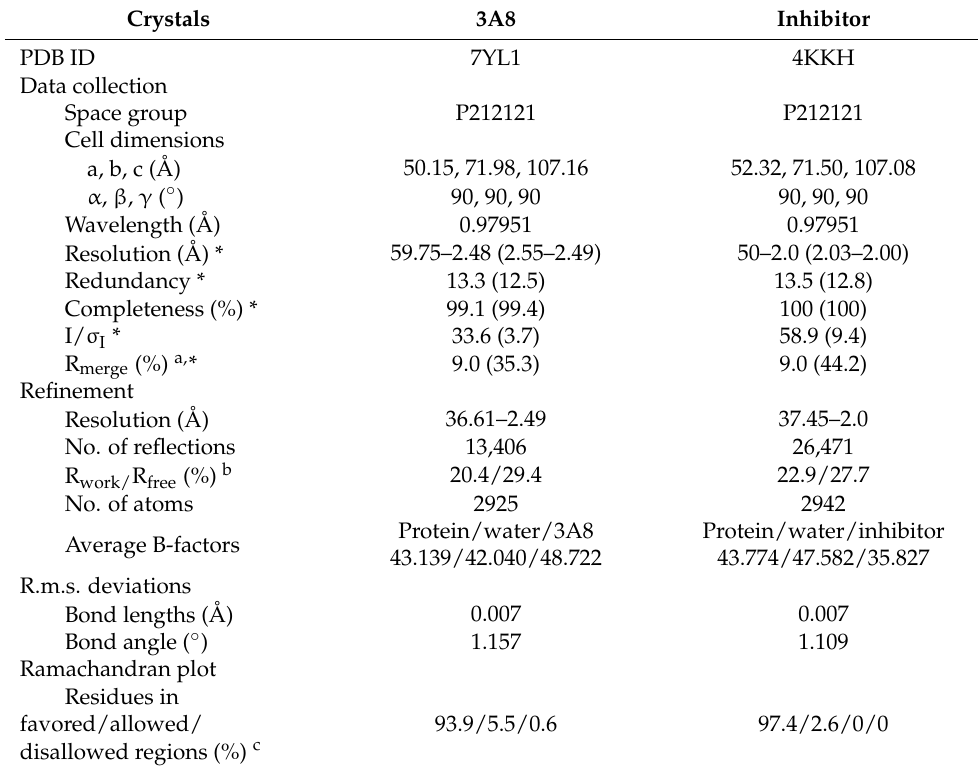
Table 1. Data collection and refinement